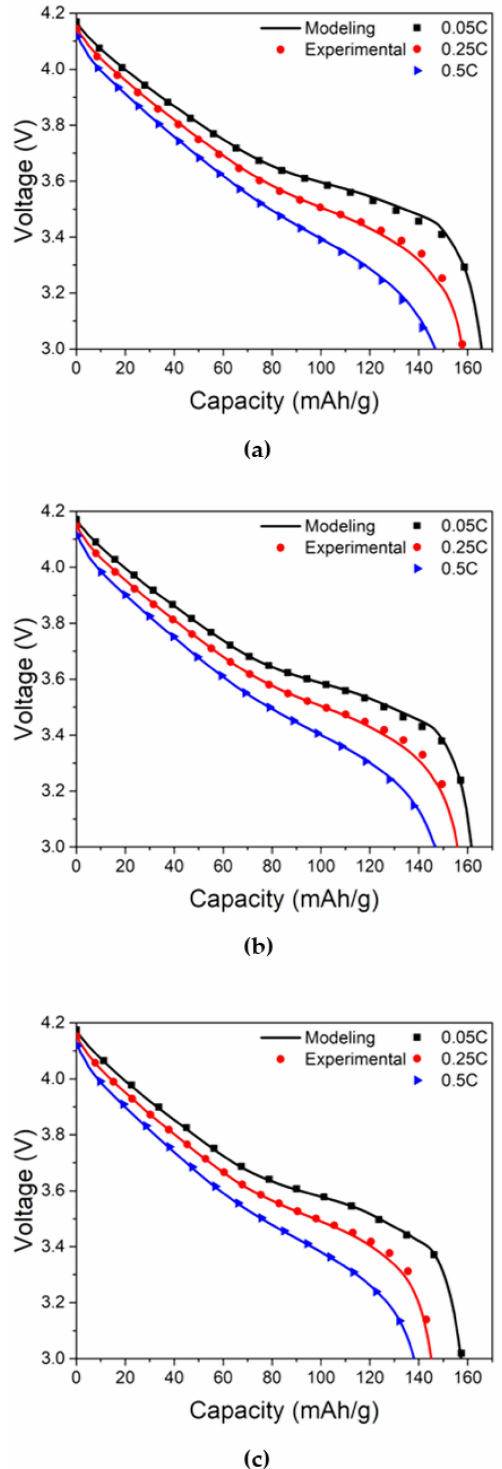
Figure 5. Comparison between the discharge behaviors calculated from the modeling and those measured by experiments with current rates ranging from 0.05 C to 0.5 C for the LIB cells having no loss of cyclable lithium with three levels of electrolyte depletion: ( a ) cell 1; ( b ) cell 2; and ( c ) cell 3. The solid lines denote modeling results and symbols are the experimental